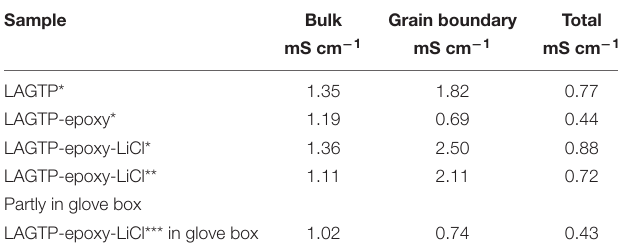
TABLE 1 | Conductivity data of LAGTP-E-LiCl at 25 ◦ C.